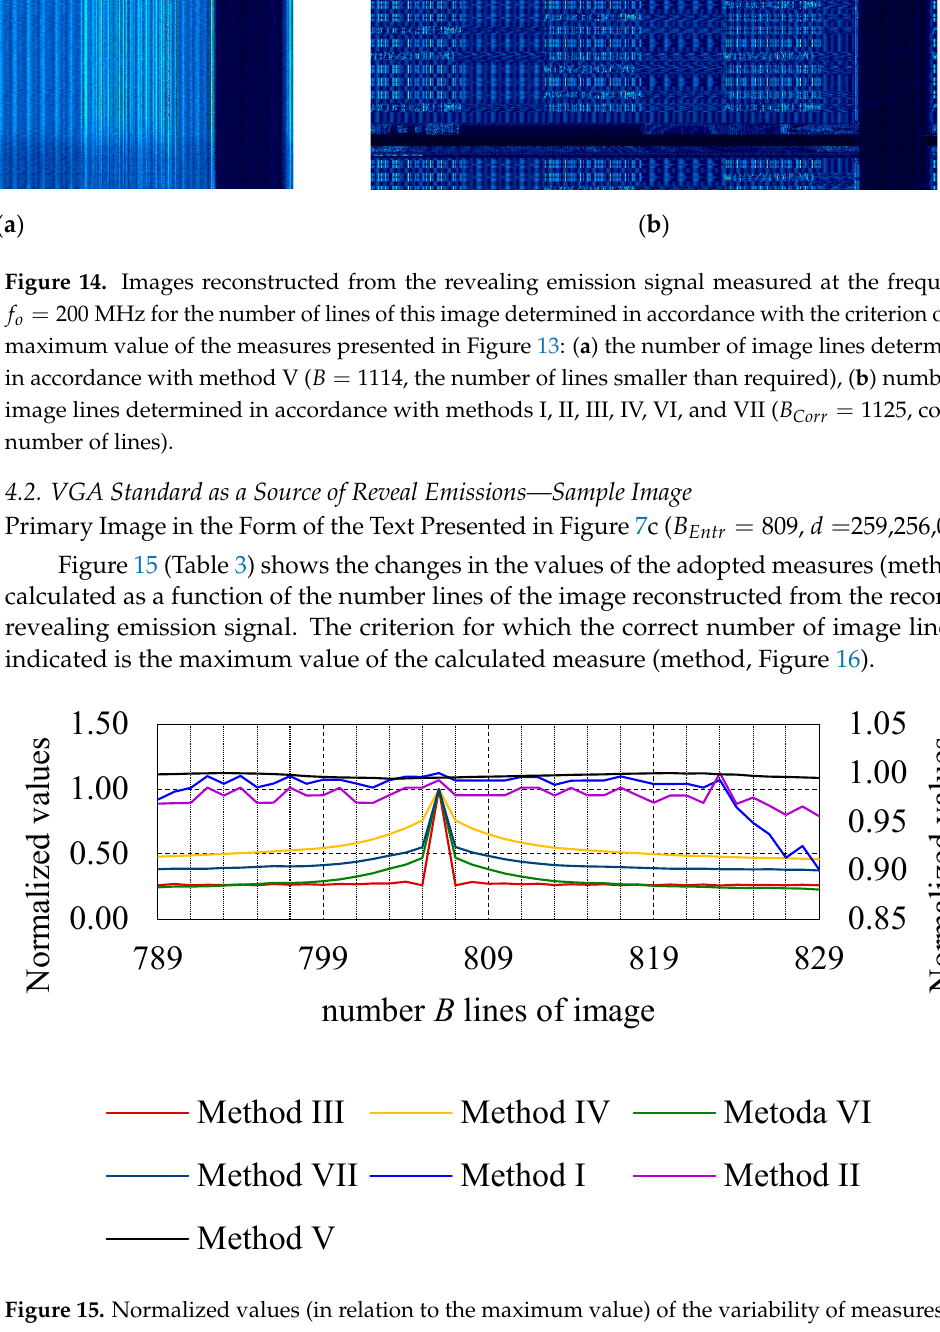
= (cid:3042) = 1125 , correct (cid:3004)(cid:3042)(cid:3045)(cid:3045)